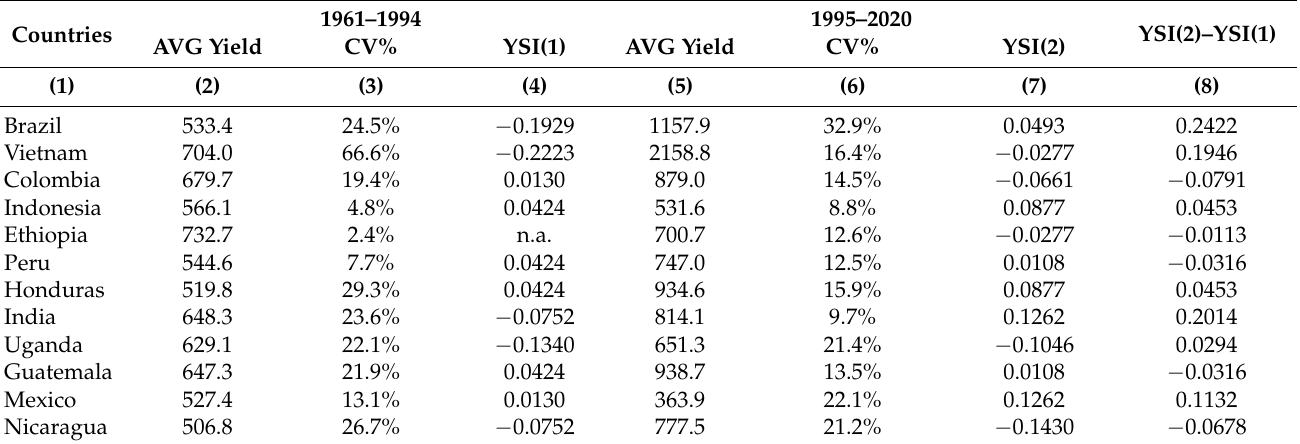
Table 6. Average yields and yield fluctuations for 1961–1994 and